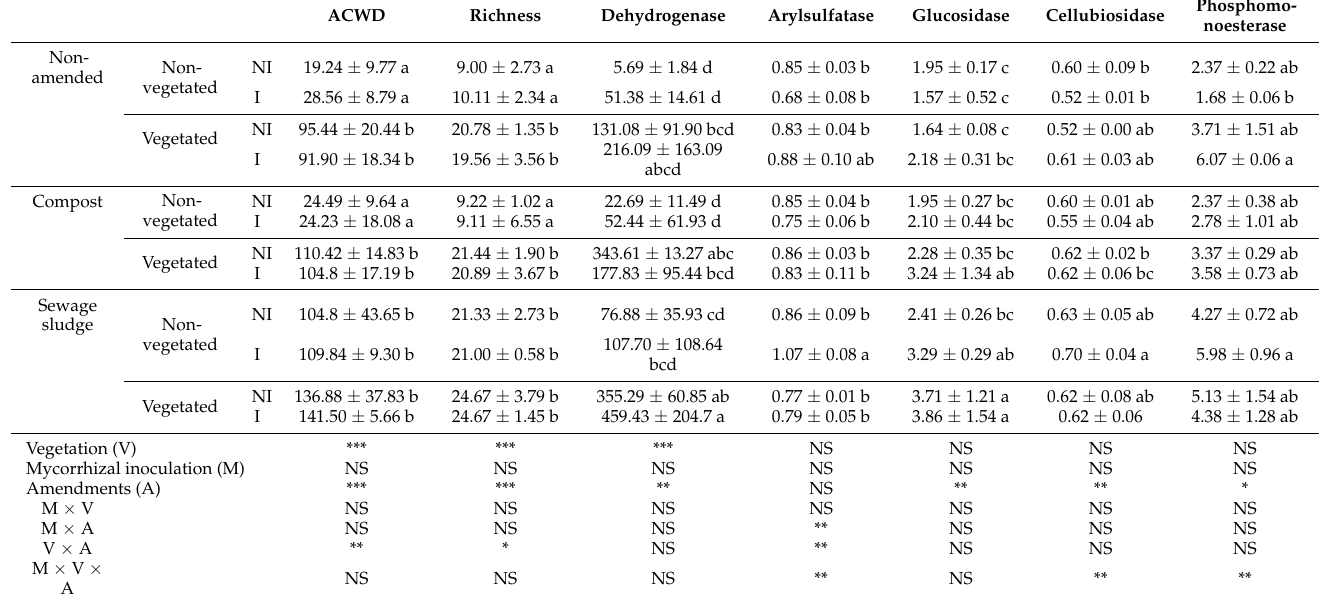
Table 4. Microbial functional diversity assessed by the total degradation activity (AWCD: average well color development), richness calculated from the substrate utilization pattern (31 substrates), and soil enzyme activities ( µ mol activity g soilDW/H) in the different soil treatments (n =